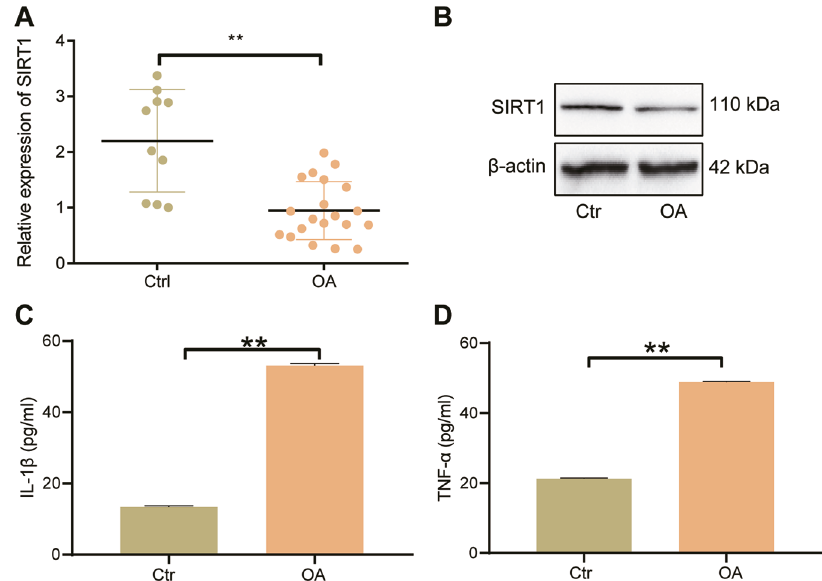
Fig. 2 Quanti fi cation of SIRT1 expression and in fl ammatory factor production in patients with OA. A qRT-PCR to detect the expression of SIRT1 mRNA in normal cartilage tissue ( n = 10) and OA cartilage tissue ( n = 20). B Western blot to detect the expression of SIRT1 protein in normal cartilage tissue ( n = 10) and OA cartilage tissue ( n = 20). C ELISA to detect the level of IL-1 β in serum of OA patients ( n = 20). D ELISA to detect the level of TNF- α in serum of OA patients ( n = 20). ** p < 0.01 compared with Ctrl